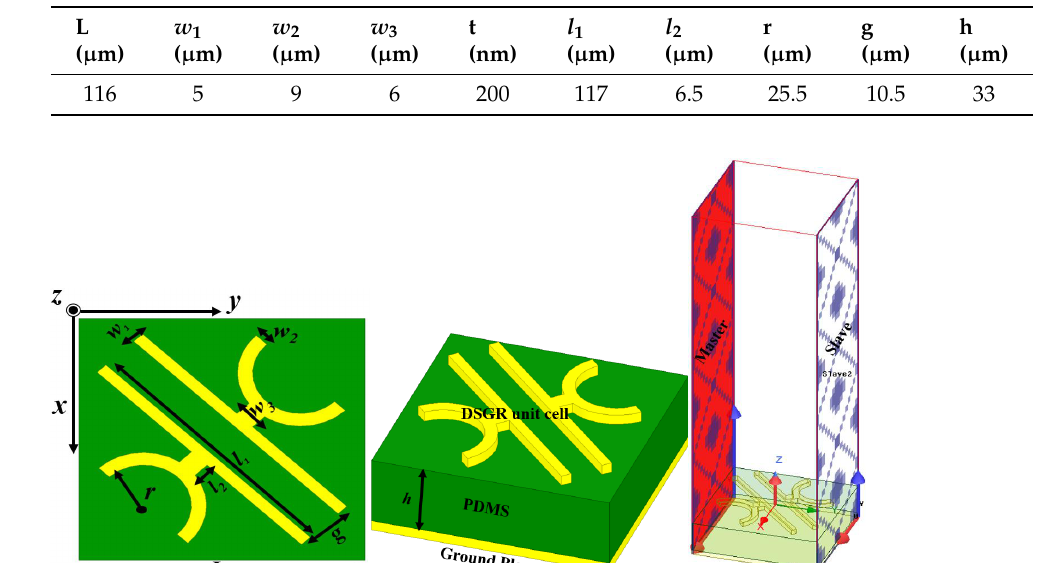
Table 1. Design parameters of the proposed broadband polarisation converter.